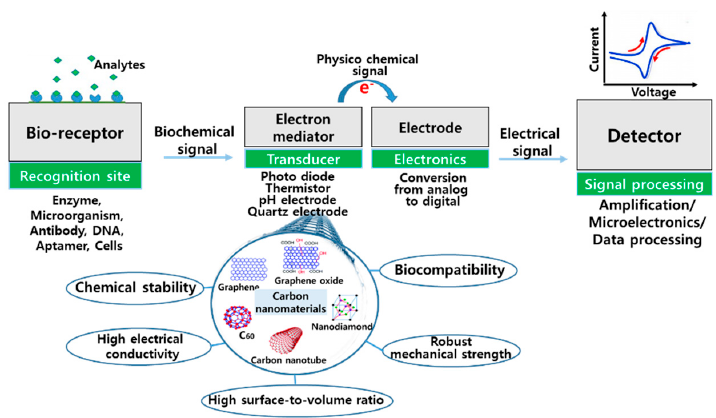
Figure 1. Components and the involved mechanism of a conventional biosensor where carbon nanomaterials (e.g., CNT, graphene, nanodiamond, fullerene) can be used as a transducer.